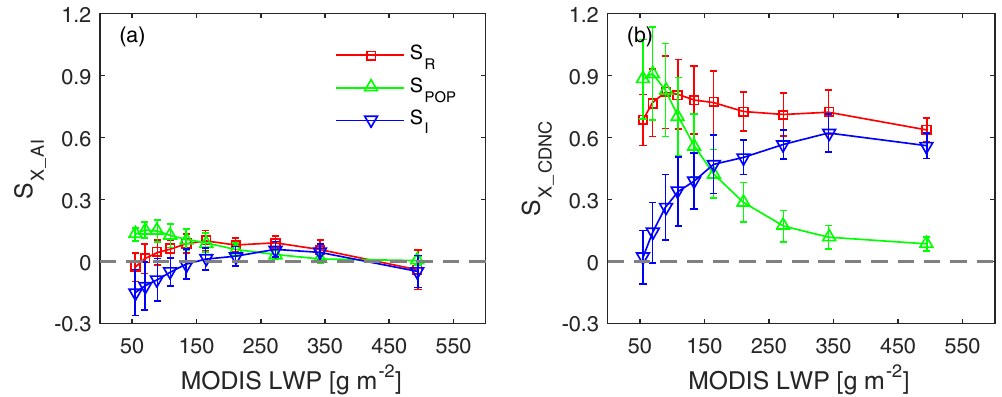
Figure 1. S POP , S I , and S R as a function of MODIS LWP with (a) AI and (b) CDNC. Red squares, green upward triangles, and blue downward triangles stand for S R , S POP , and S I , respectively. Error bars are based on 95% confidence intervals for the susceptibility estimates. AI is derived from MYD04/MODIS and CDNC is estimated from MYD06/MODIS. Intensity and probability of precipitation are based on the 2B-GEOPROF product with a − 15dBZ threshold. The total amounts of data samples for the left panel and right panel are about 2.1 and 3.1